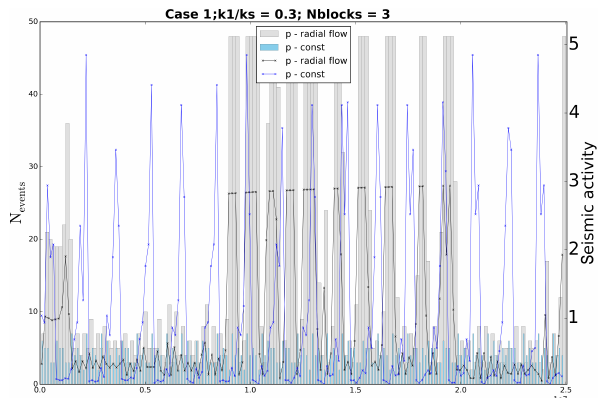
Figure 32. Time variation of seismic activity.